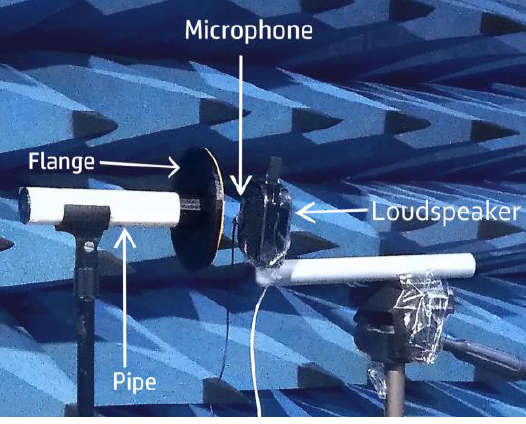
Figure A2. Schematic of the experimental setup.